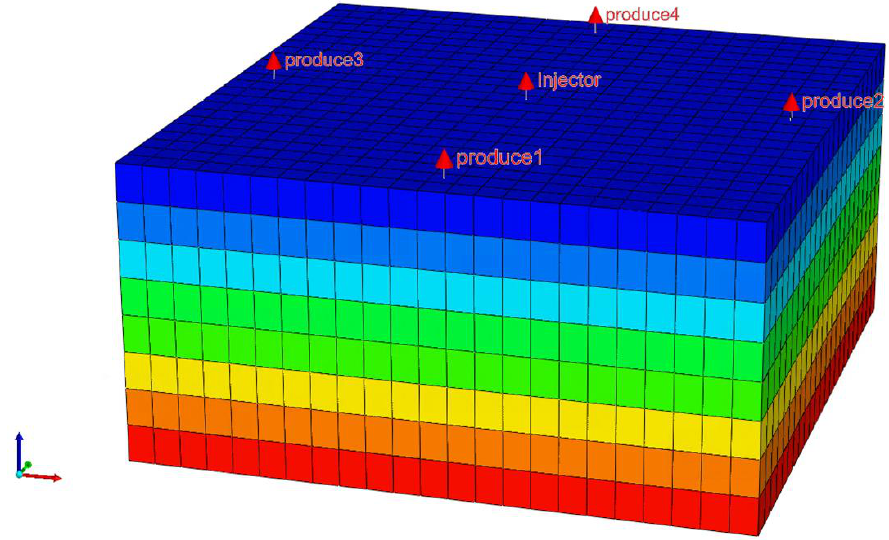
Figure 1. Three-deminsional diagram of the Water Alternating Gas model.